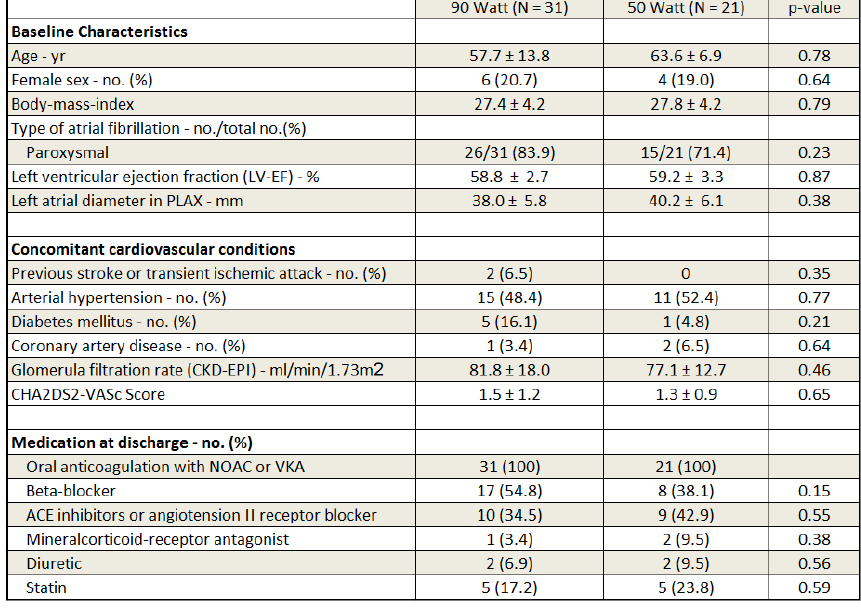
Figure 1. Patient characteristics at